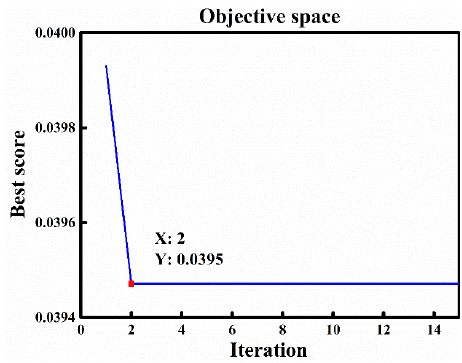
Figure 3. WOA convergence curve for VMD parameter optimization.